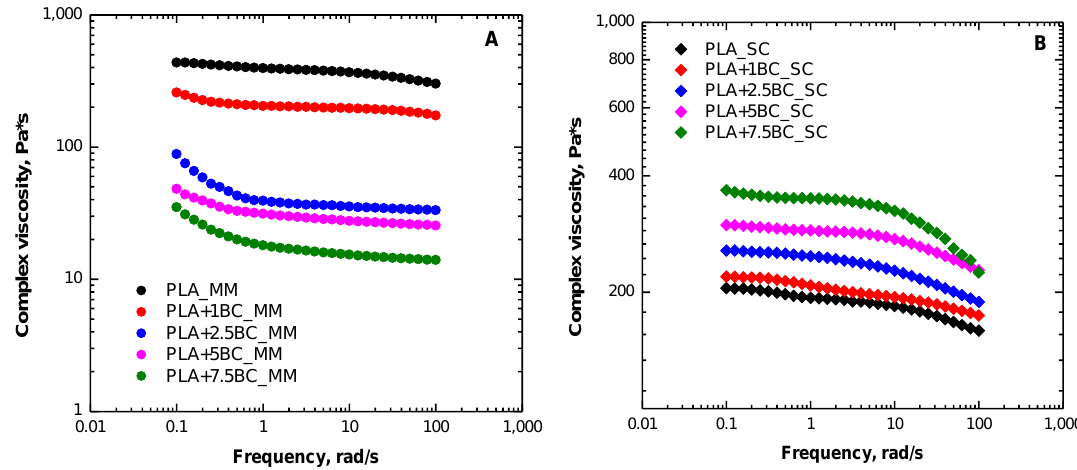
Figure 1. Complex viscosity as a function of frequency for neat poly(lactic acid) (PLA) and biochar (BC)-containing composites obtained through melt mixing (MM) ( A ) and solvent casting (SC) ( B ).